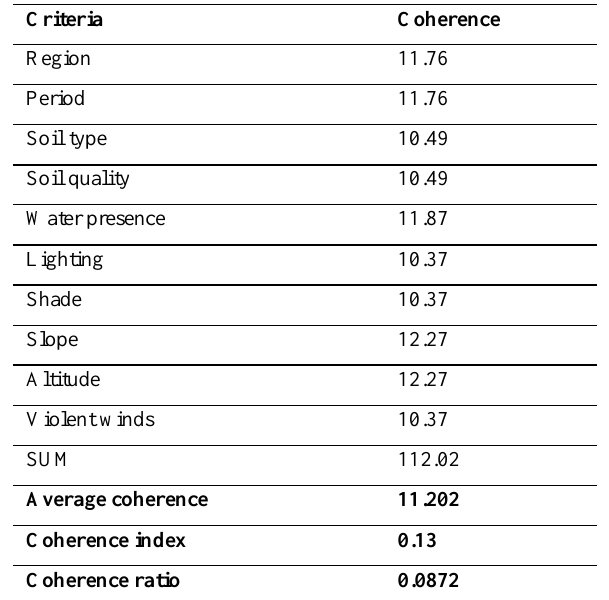
Table 6. Average coherence